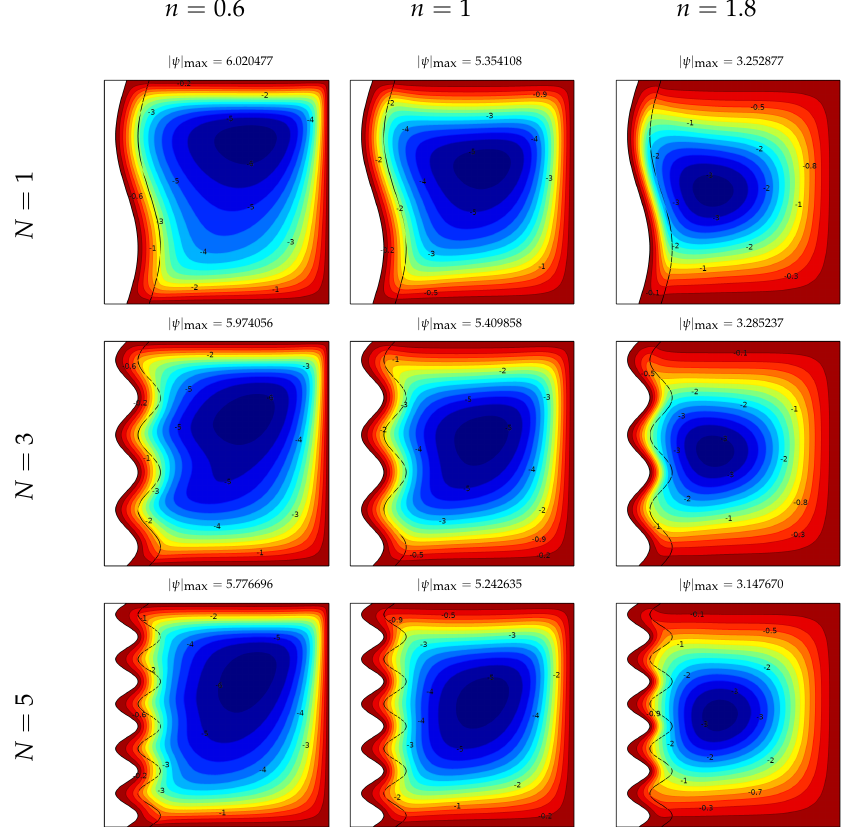
Figure 7. Streamlines for different values of power law indices n and undulations N